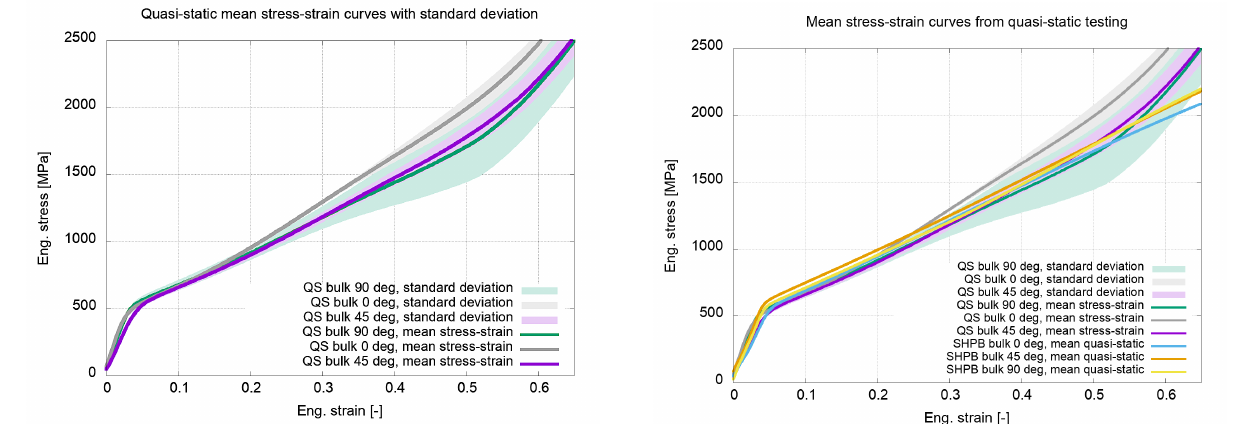
Figure 6. Mean stress-strain curves for cylindrical and dog bone shaped specimens evaluated from quasi- static